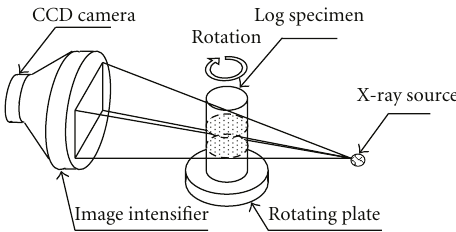
Figure 2: The block diagram of X-ray wood nondestructive detection imaging system.